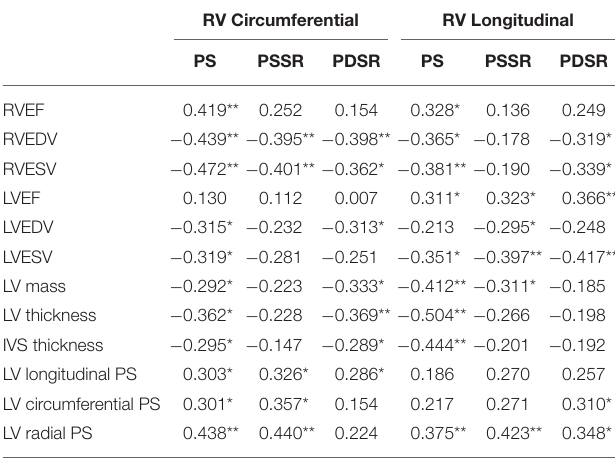
TABLE 2 | Comparison of cardiac magnetic resonance parameters between two groups. Variables